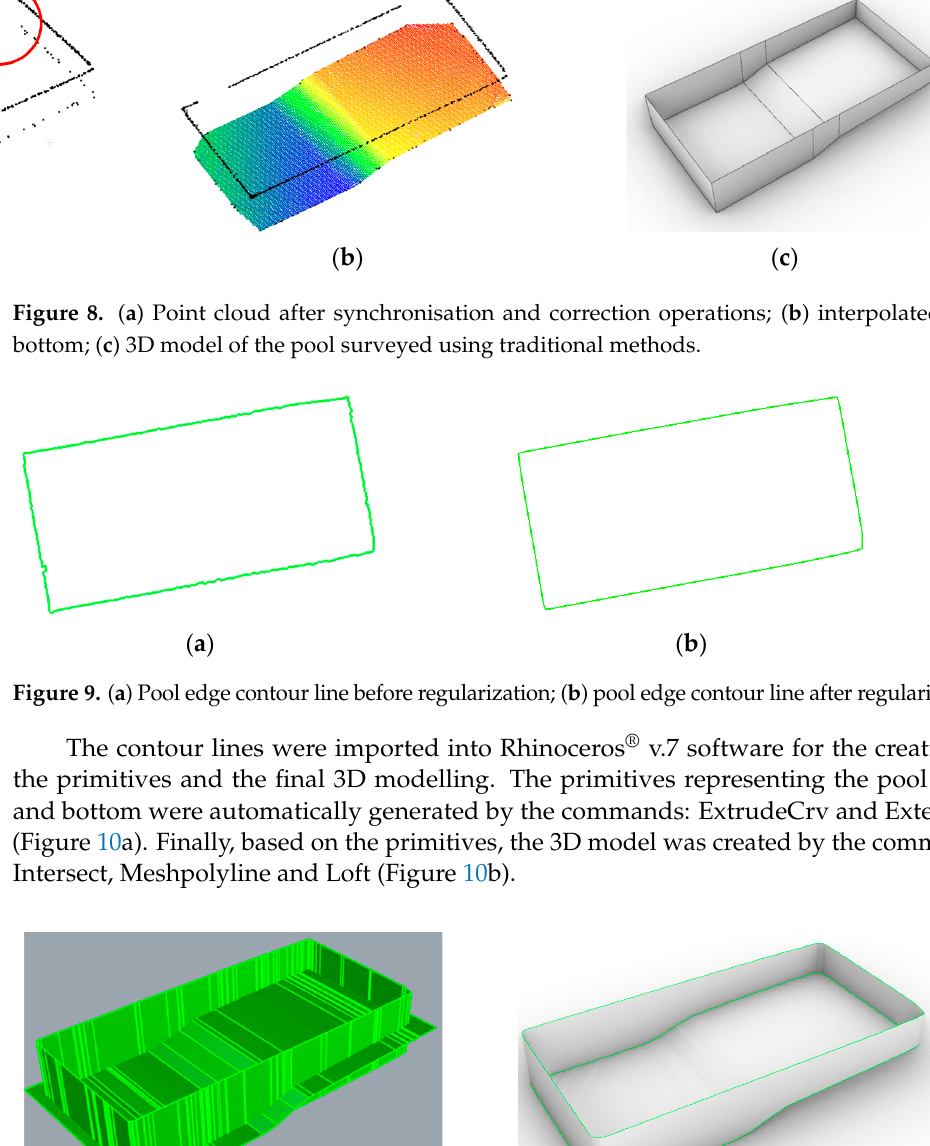
Figure 10. ( a ) Primitives representing the walls and bottom of the pool; ( b ) final 3D model of the pool.